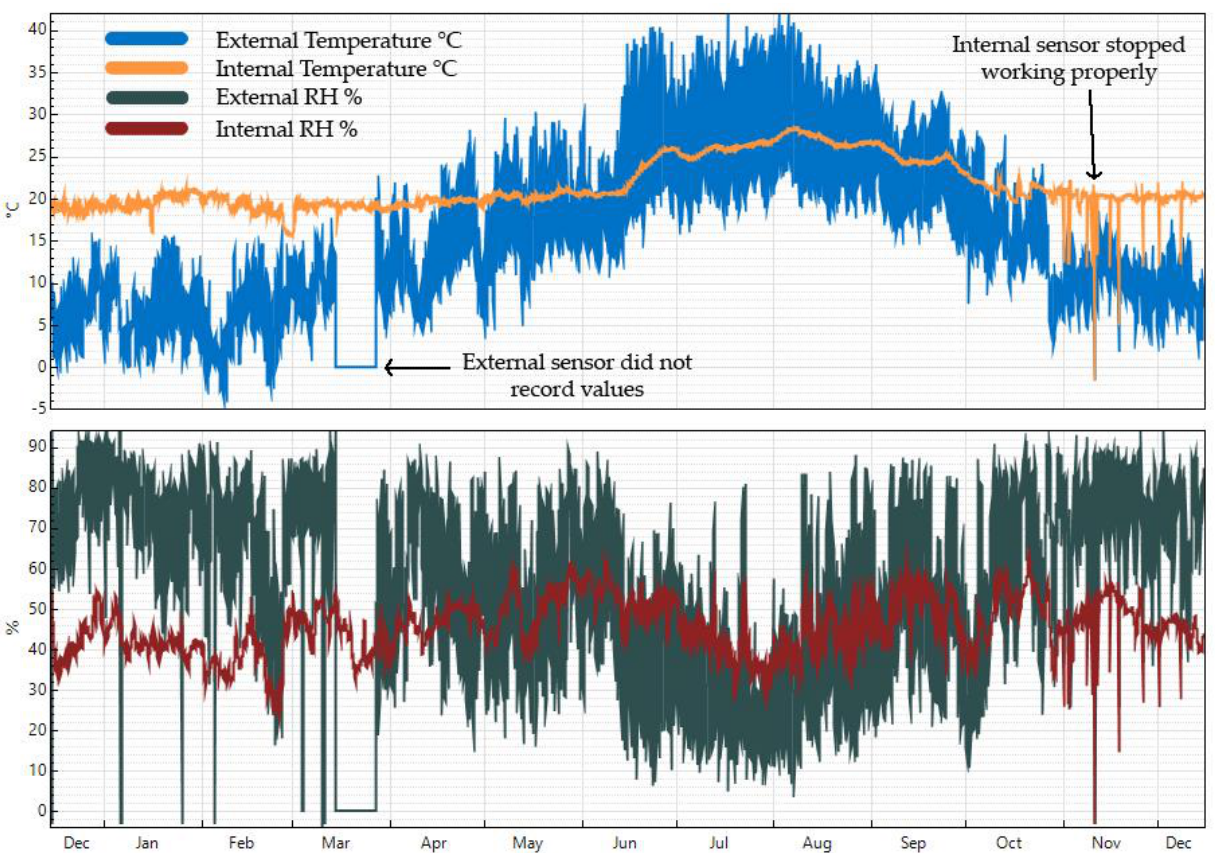
Figure 3. Internal and external temperature and relative humidity. 14 December 2017 – 15 December 2018.